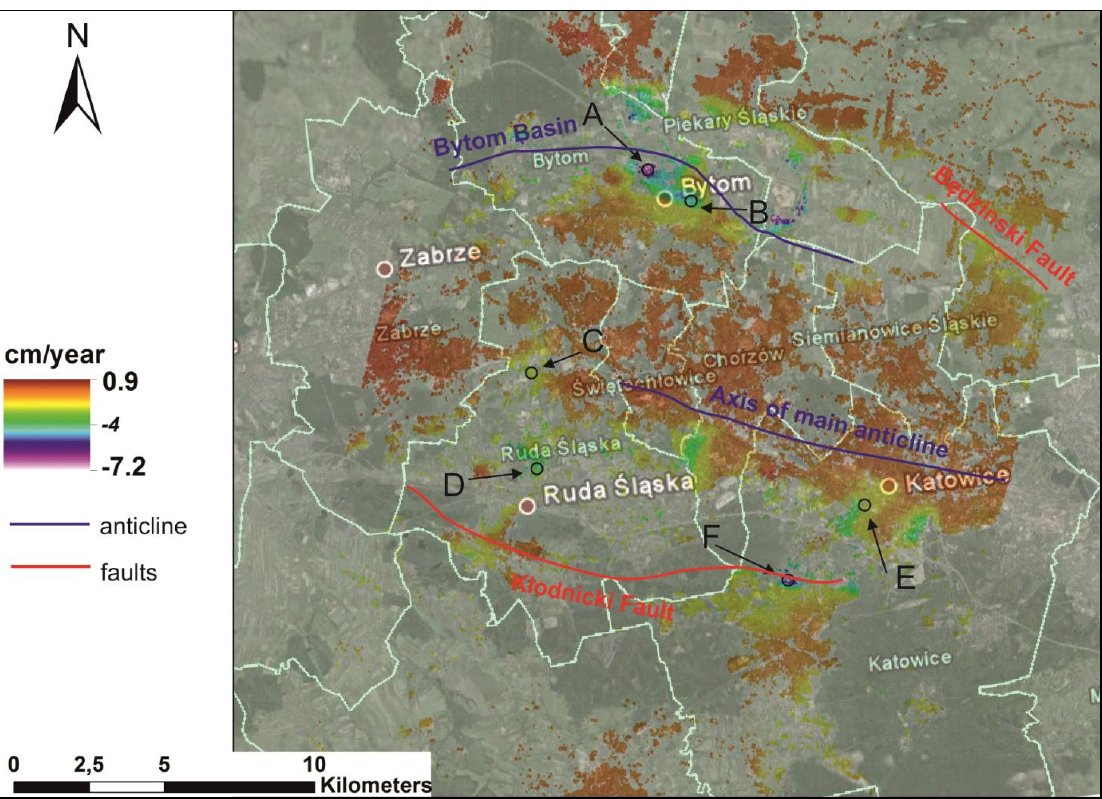
Fig. 5. The results of SBAS (Small BAseline Subset) technique used 31 ERS-2 images from the 1995-2000 period. The signed representative points on map are related to the time series analysis on Fig. 6. The anticlines and faults based on Graniczny et al., 2011